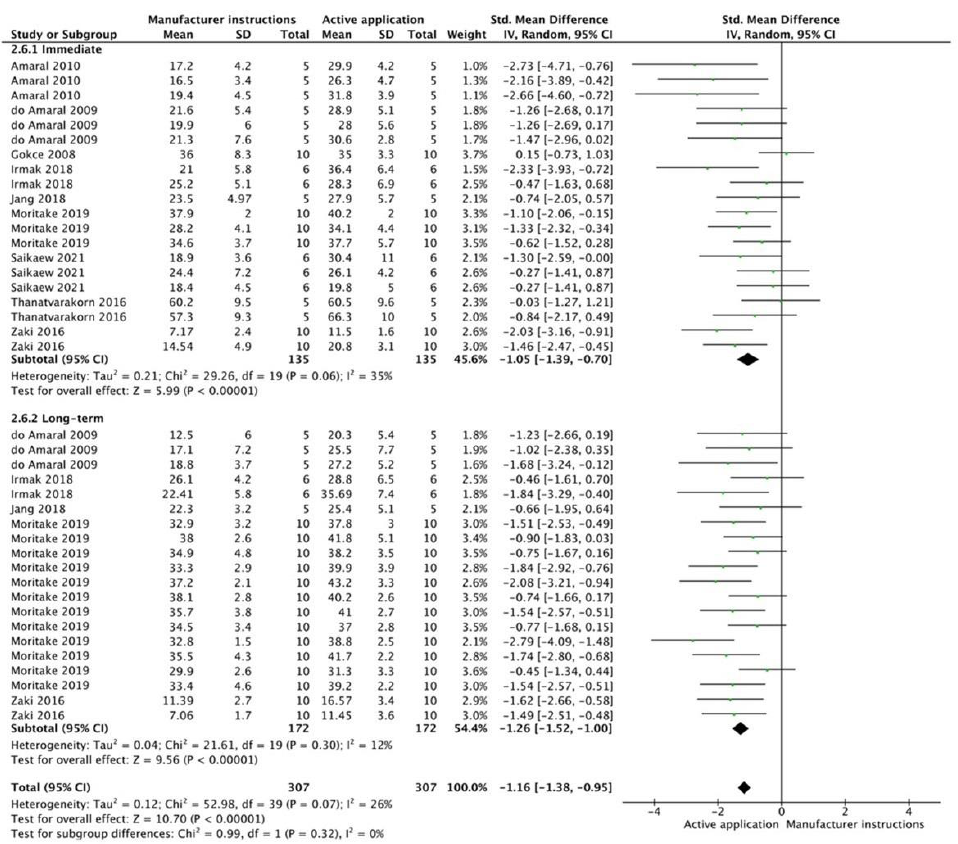
Figure 11. Forest plot showing the bond strength values when the adhesive was applied using an electric current.